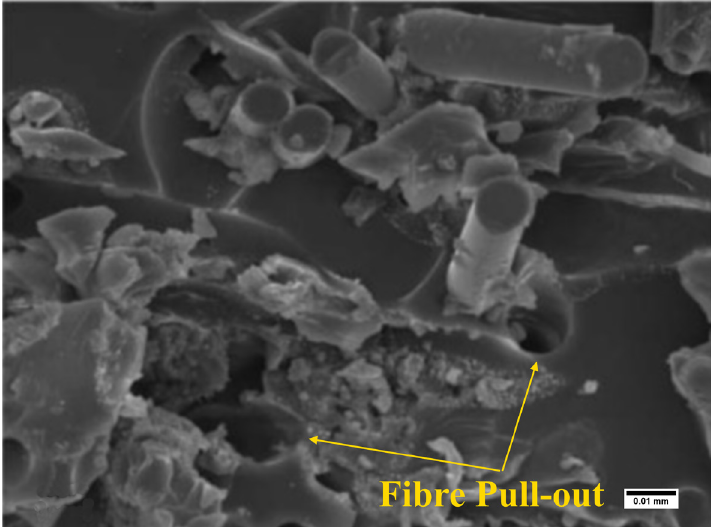
Figure 9. SEM micrography where the pull-out mechanism of rGFs is evidenced [90]. Jiang et al. [91] used microwave-assisted pyrolysis in an inert atmosphere with a tem- perature variation in the range of 400–600 °C for a period of treatment of 30 min to recycle CFs.